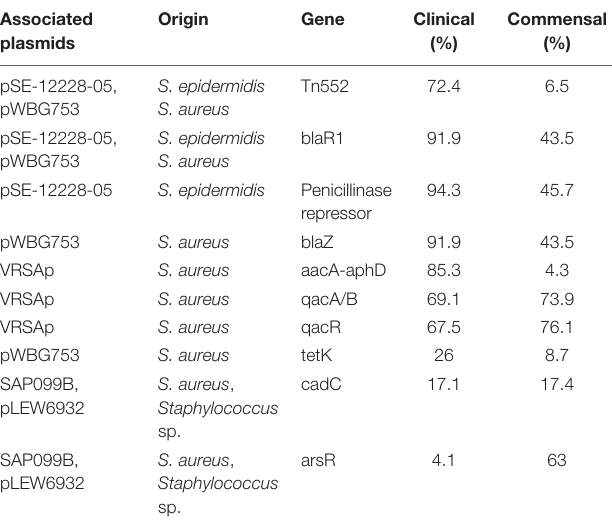
TABLE 3 | Distribution of genes associated with larger plasmids in the